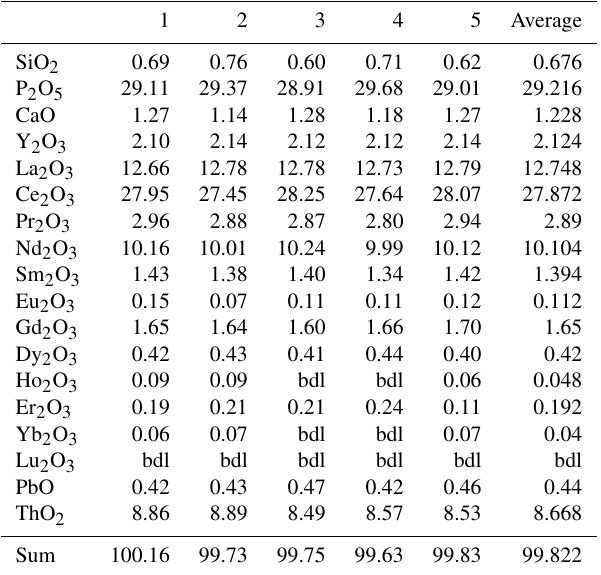
Figure 2. Thin section under crossed nicols (Mnz: monazite; Qtz: quartz; All: allanite + quartz + apatite; Py: pyrite). The monazites show strong birefringence (interference colors). Table 3. Chemical composition of the REE-bearing monazites (wt%) from five locations and the average of them (below detec- tion limit (bdl) is counted as 0). Microprobe analyses. Chemical composition of monazites along the mapped profile in sample STK115c